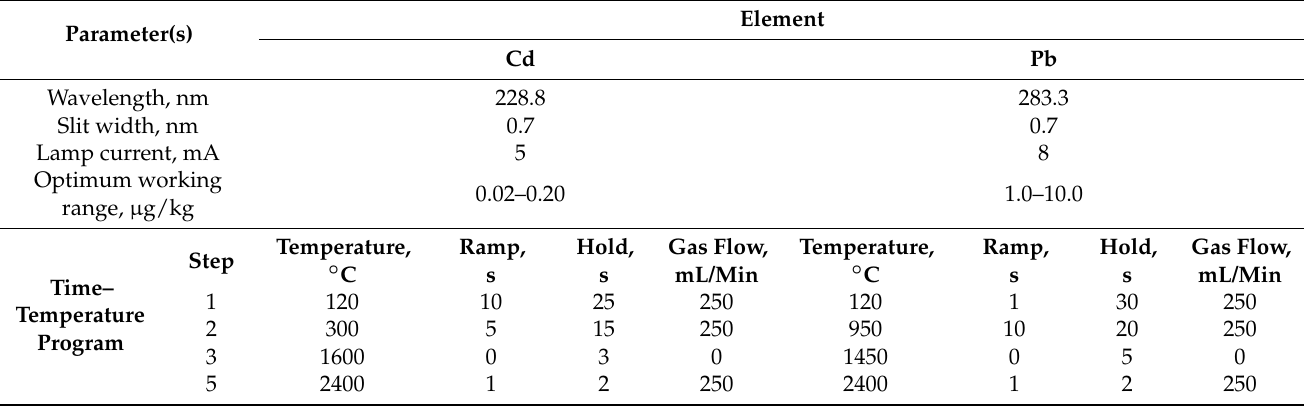
Table 2. Brief description of instrumental and experimental conditions for determinations of Cd and Pb in HMP with Mentha × piperita L., folium.